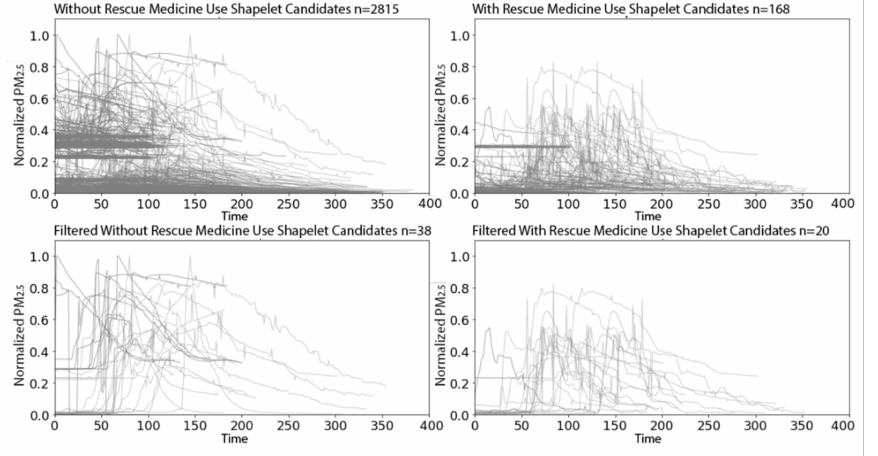
Figure 13. W-TSS shapelets from indoor PM2.5 time series before filtering ( top row ) and after filtering ( bottom row ) for days without rescue medicine use ( left ) and days with use ( right